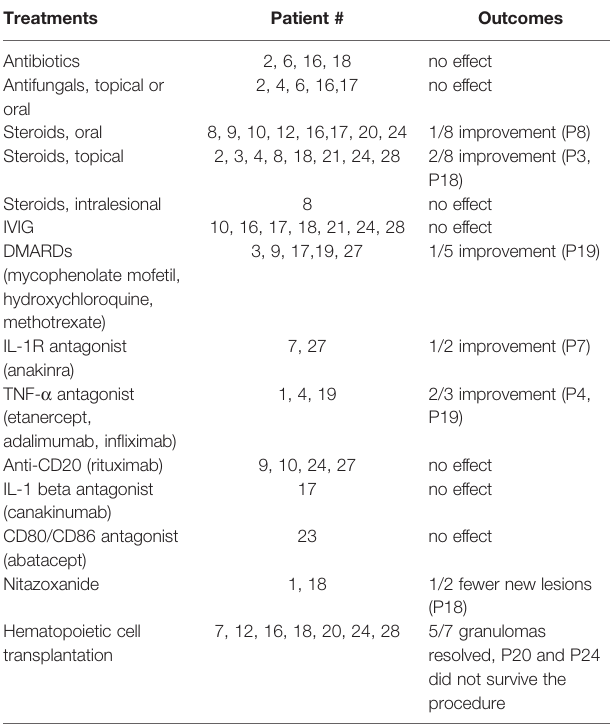
TABLE 2 | Treatment response in 28 patients with